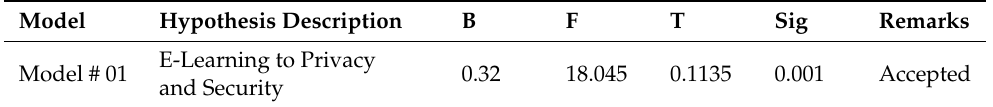
Table 4. Hypothesis testing of H1.